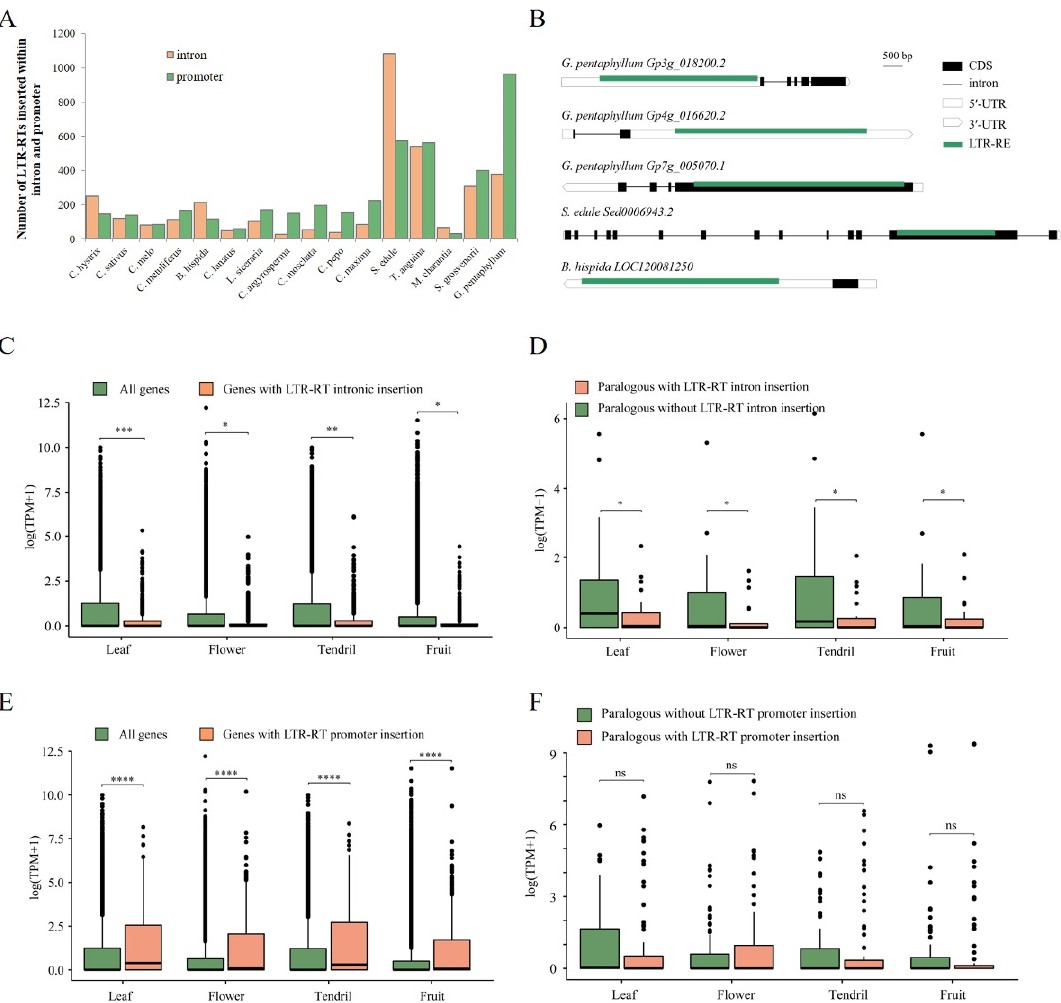
Figure 7. Impact of LTR ‐ RTs on gene structure and expression. ( A ) Number of genes with LTR ‐ RT insertions in introns or promoters; ( B ) LTR ‐ RTs reside within the exons of five genes from three species; ( C ) comparison of gene expression levels between the genes with intronic LTR ‐ RT insertions and the whole gene set in four tissues of G. pentaphyllum ; ( D ) gene expression levels of paralogous gene pairs with or without intronic LTR ‐ RT insertion in four tissues of G. pentaphyllum ; ( E ) comparison of gene expression levels between the genes with promoter LTR ‐ RT insertions and the whole gene set; ( F ) gene expression levels of paralogous gene pairs with or without promoter LTR ‐ RT insertion. p **** < 0.0001; p *** < 0.001; p ** < 0.01; p * < 0.05. ns represents p > 0.05.